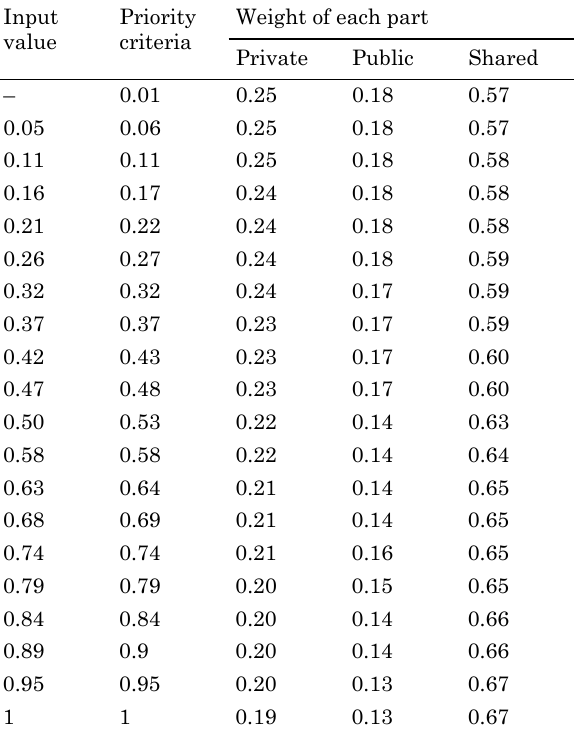
Table 13. Various values and sensitivity analysis based on r criterion 18